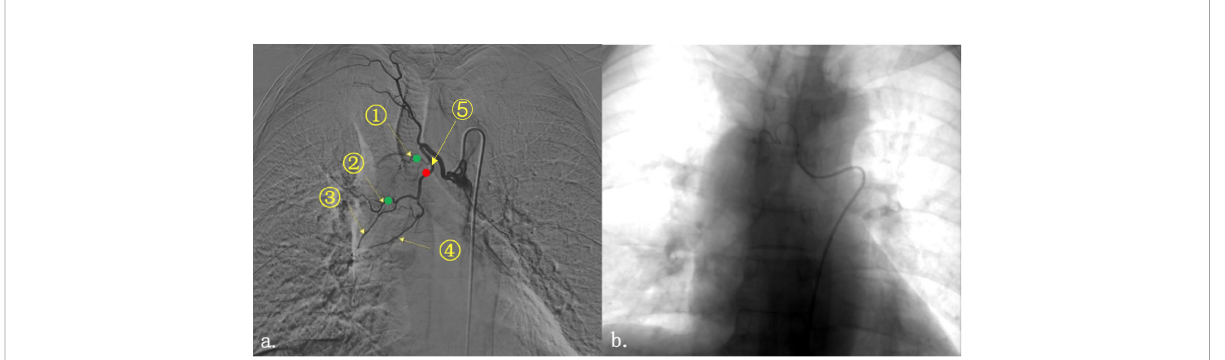
FIGURE 2 Imaging of tumor under contrast medium perfusion. Right bronchial artery angiography showed that the tumor at the right hilum was mainly supplied by two blood vessels (A) . They are (1) the right upper lobe bronchial artery; (2) the right middle lobe bronchial artery; (3) the right bronchial artery fl owing through part of the middle lobe and lower lobe; (4) the right inferior lobe bronchial artery; and (5) the trunk of the right middle and lower lobe bronchial artery. The red dot represented the general location of the fi rst embolization; and the green dot represented the location of the second one. (B) The bronchial artery was embolized by injection of microspheres and coils until the vascular enhancement image